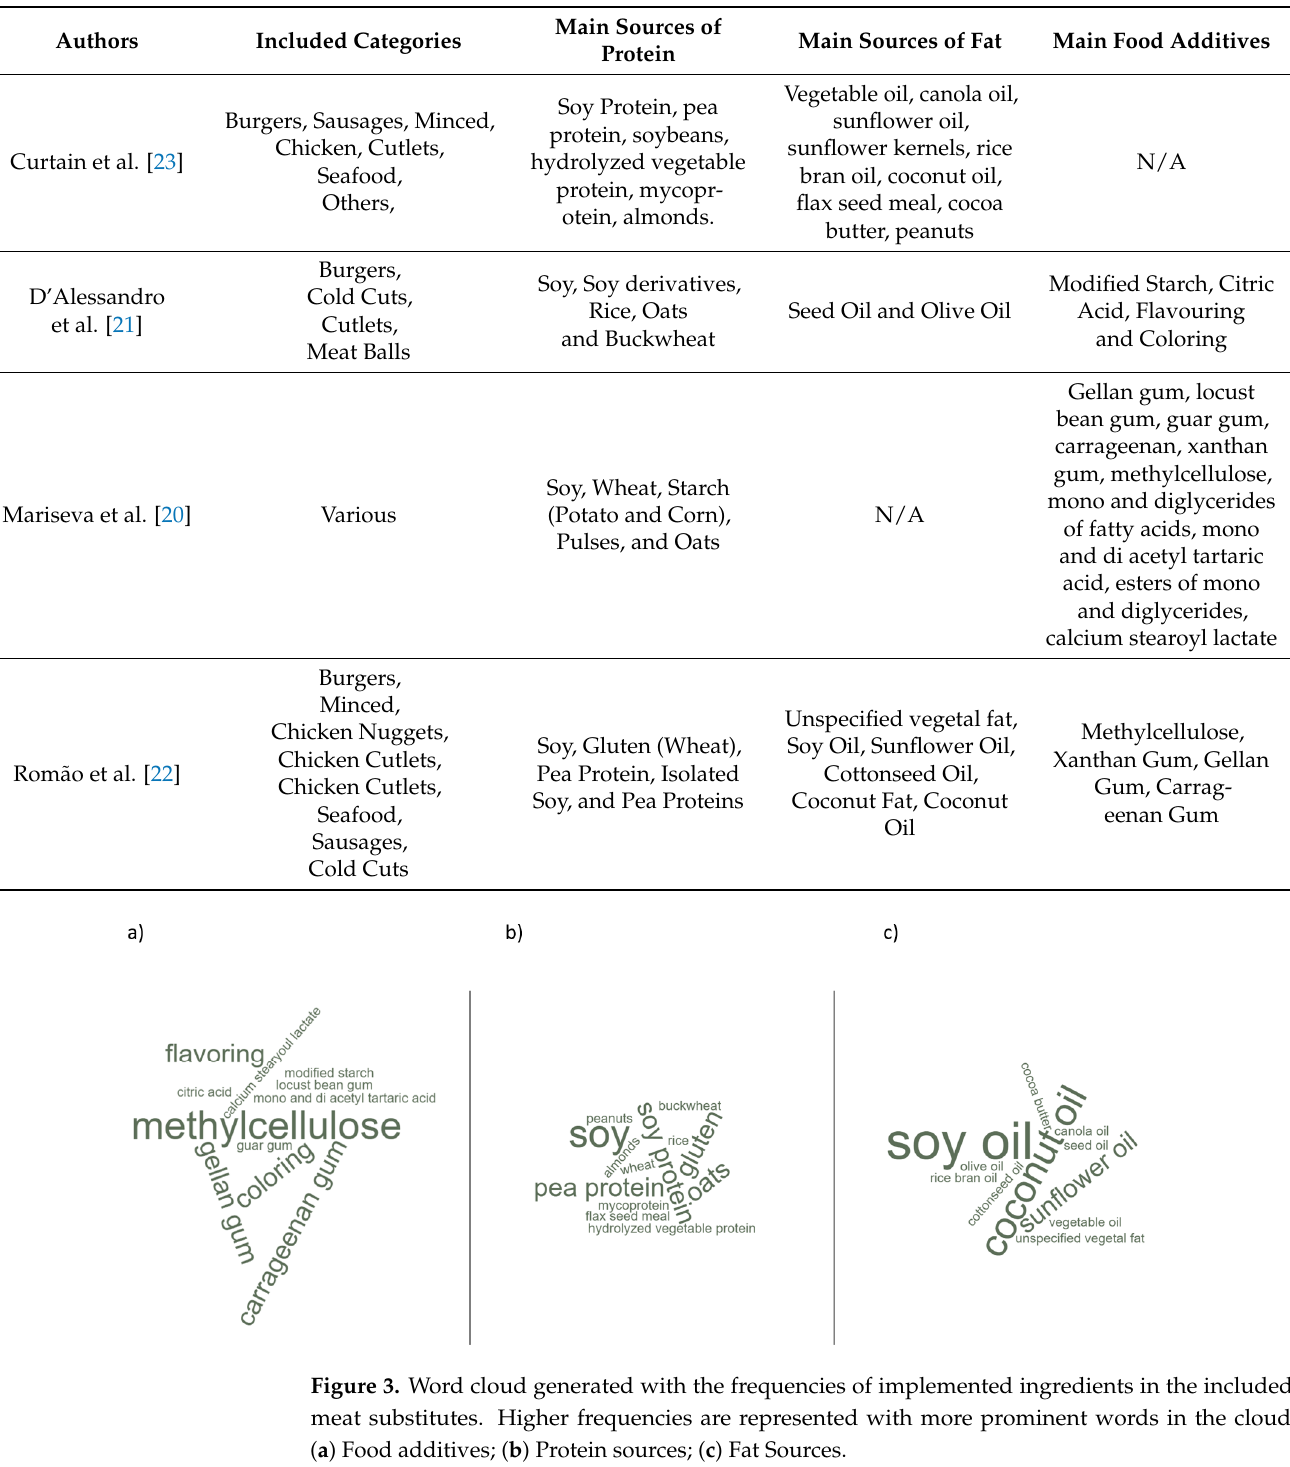
Table 3. Main ingredients in meat substitutes available in the included studies.